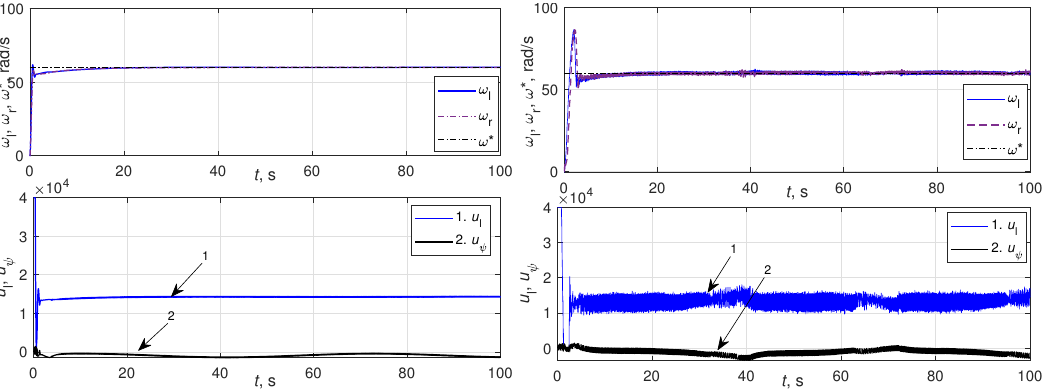
Figure 9. Simulation ( left column ) and experiment ( right column ). ω l ( t ) , ω r ( t ) , ω ∗ ( t ) ( upper plot ) and control actions u l ( t ) , u ψ ( t ) ( lower plot ) time histories for ψ ∗ = π sin ( 0.1 t ) .